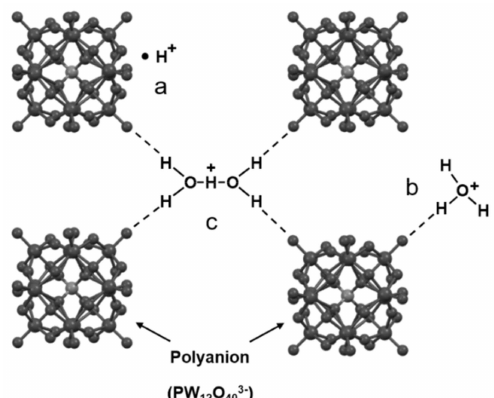
Figure 2. Protonic species in H 3 PW 12 O 40 · nH 2 O (0 < n < 6); ( a ) the isolated acidic proton; ( b ) H 3 O +